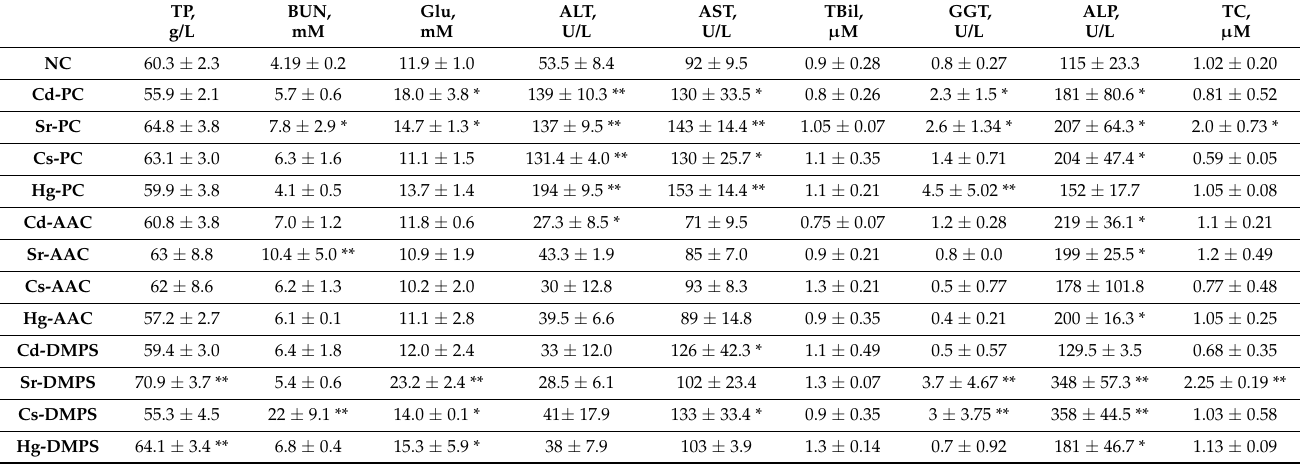
Table 2. Effect of heavy metals on the blood biochemical markers in the experimental